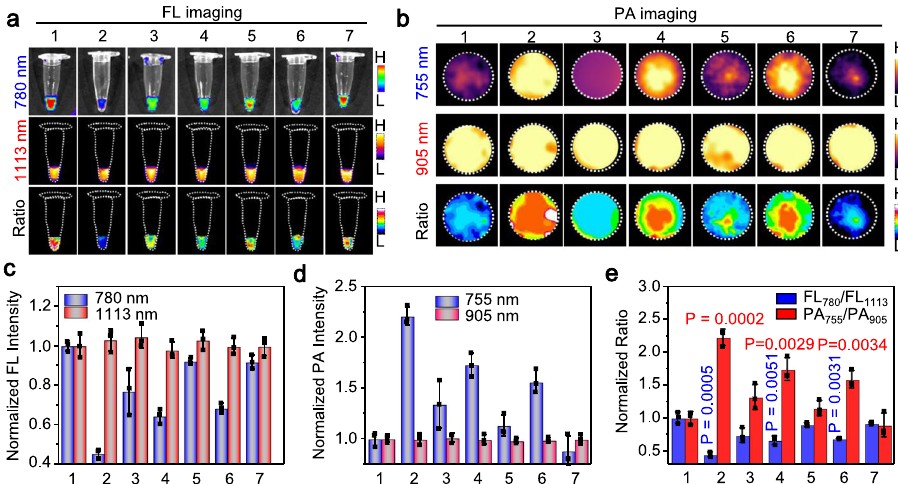
Fig. 4 Ratiometric near-infrared fl uorescence/photoacoustic imaging of intracellular (cid:129) OH. a Fluorescence (FL) (780 and 1113 nm) and ratiometric FL 780 / FL 1113 images, and b Photoacoustic (PA) images (755 and 905 nm) and ratiometric PA 755 /PA 905 images of RAW264.7 cells (~5 × 10 5 cells) upon treatment with 1-NP (56/1.65/20 μ M 1-Br-Et/NIR775/IR1048) for 3 h plus different conditions. 1: Ctrl; 2: 200 μ M Fe 2 + + 1 mM H 2 O 2 ; 3: 200 μ M Fe 2 + + 1 mM H 2 O 2 + tempol (200 μ M); 4: Lipopolysaccharide (LPS) (20 μ g mL − 1 ); 5: LPS (20 μ g mL − 1 ) + tempol (200 μ M); 6: Phorbol 12-myristate 13-acetate (PMA) (20 μ g mL − 1 ); 7: PMA (20 μ g mL − 1 ) + tempol (200 μ M). c Normalized FL and d PA intensities of RAW264.7 cells under indicated treatment. e Normalized FL 780 /FL 1113 ratios and PA 755 /PA 905 ratios of RAW264.7 cells under indicated treatment. Data are presented as mean ± s.d. ( n = 3 independent cell pellets). Statistical differences were analyzed by Student ’ s two-sided t -test between Ctrl and indicated groups. Source data are provided as a Source Data fi